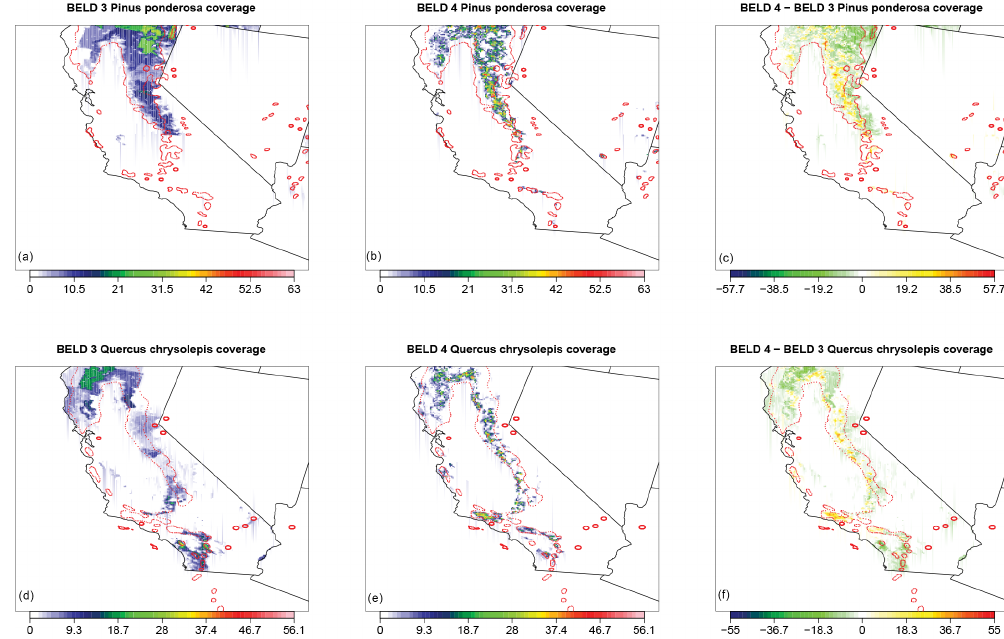
Figure 3. BELD 3 spatial allocation of ponderosa pine ( Pinus ponderosa ) (a) , BELD 4 spatial allocation (b) , and the absolute difference between the BELD 4 and BELD 3 spatial allocation (c) . BELD 3 spatial allocation of canyon live oaks ( Quercus chrysolepis ) (d) , BELD 4 spatial allocation (e) , and the absolute difference between the BELD 4 and BELD 3 spatial allocation (f) . The natural range maps of Critchfield and Little (1966) and Little (1971, 1976) are represented by the dashed red